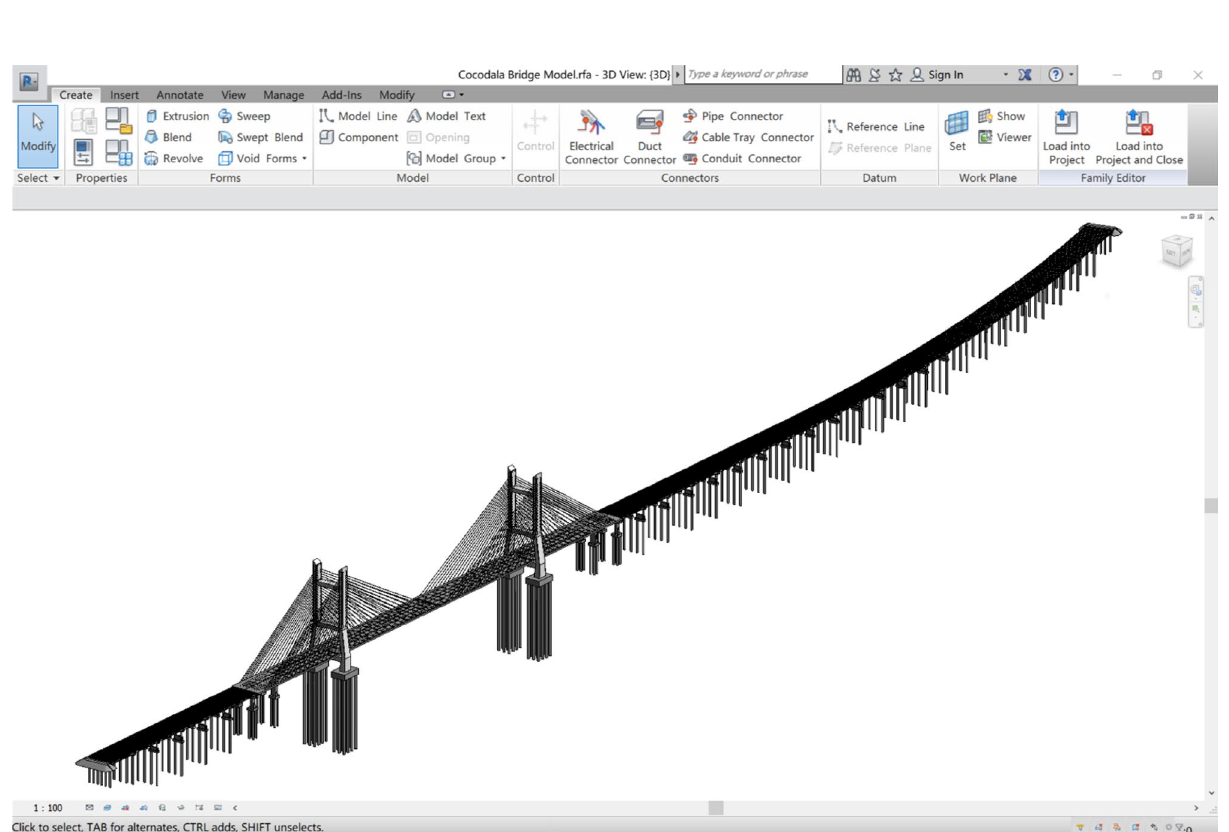
Figure 10. BIM3D model of the Cocodala